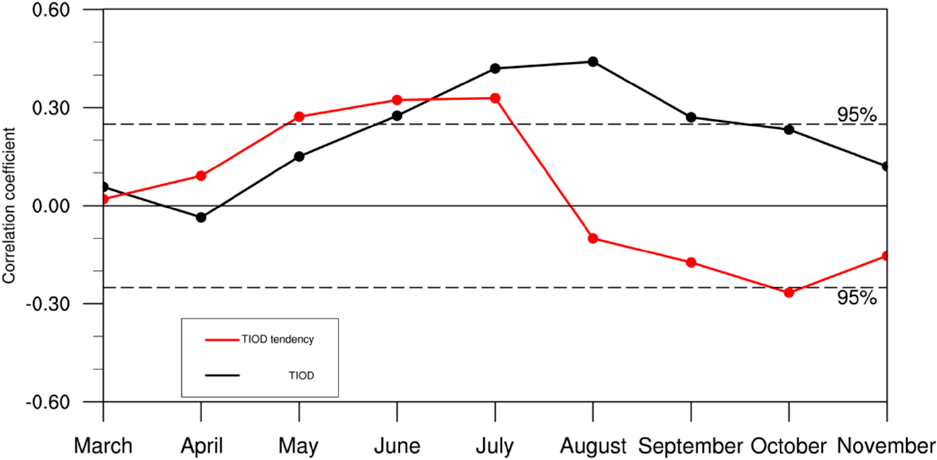
Figure 8. Lag–lead correlation between monthly TIOD indices and PC2 (black line), and between the tendency of monthly TIOD indices and PC2 (red line) for the period of 1958 to 2018. The dashed line denotes the 95% confidence level.